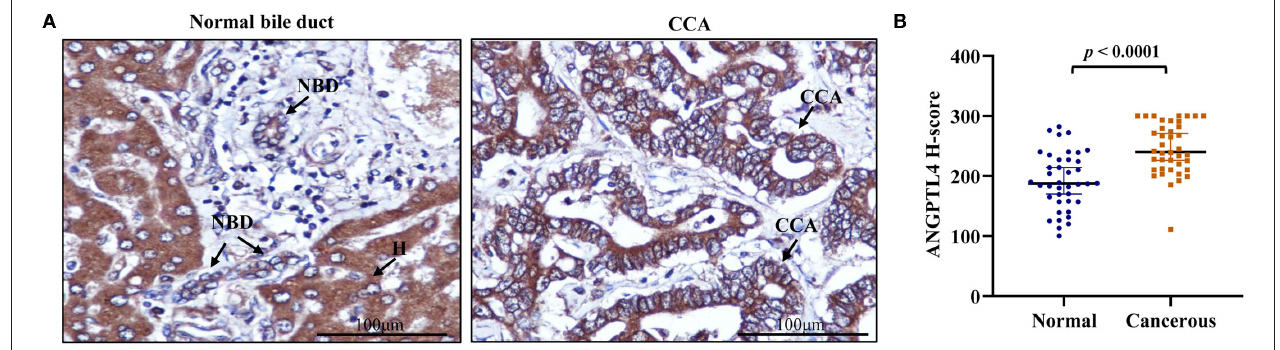
FIGURE 2 | (A) Representative immunohistochemical staining of ANGPTL4 in CCA tissues (magnification, x400). Hepatocytes (H) strongly express ANGPTL4 while normal bile duct (NBD) express weak positive staining and CCA cells express strongly positive staining. (B) H-scores of ANGPTL4 in normal and CCA tissues using immunohistochemistry. Mann-Whitney U -test was used to compare H-scores between normal and cancerous tissues of ANGPTL4. Statistical significance ( p < 0.05).